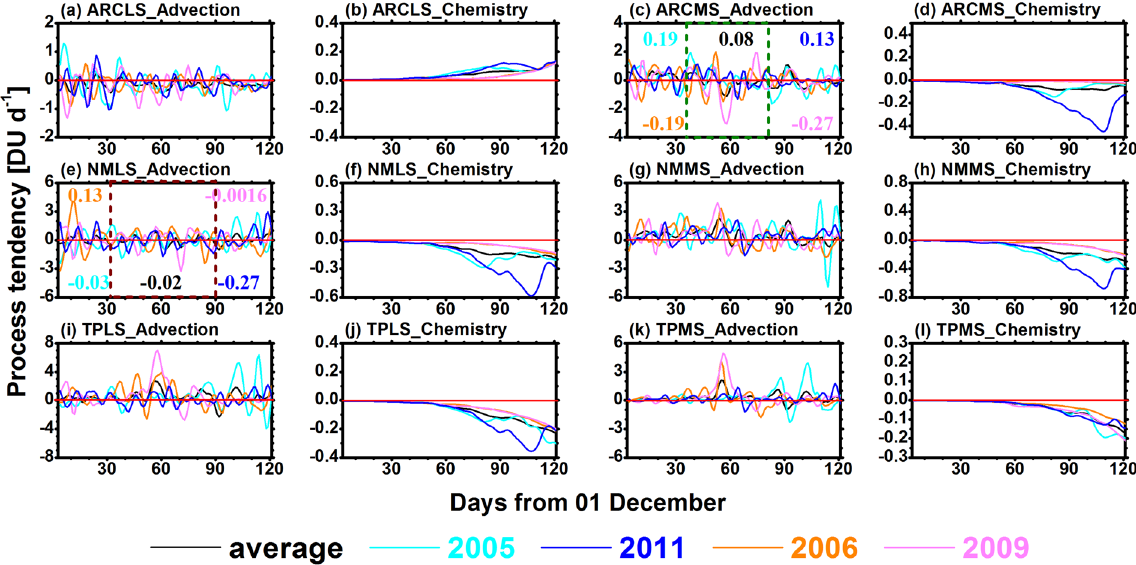
Figure 3. Time series of advective and net chemical tendencies (unit: DU d − 1 ) for ozone tracers originating from the following regions across the Arctic: ( a , b ) ARCLS, ( c , d ) ARCMS, ( e , f ) NMLS, ( g , h ) NMMS, ( i , j ) TPLS, and ( k , l ) TPMS. All values are vertically integrated results from the tropopause to 20 hPa. The black, light blue, blue, orange, and pink lines represent the 7-year average, 2005, 2011, 2006, and 2009 results, respectively. The horizontal red line is the zero line. In Fig. 3c, the data from 05 January to 18 February are marked with a dark- green dashed box, which indicates when the mean advective tendencies during cold (warm) winters were above average (below average). Similarly, in Fig. 3e, data from 01 January to 28 February are marked with a dark-red dashed box, which indicates when the mean advective tendencies during cold (warm) winters were below average (above average). The black, light blue, blue, orange, and pink numbers in Fig. 3c,e represent the mean advective tendencies (unit: DU d − 1 ) during the periods within dashed boxes for the 7-year average, 2005, 2011, 2006, and 2009 results,